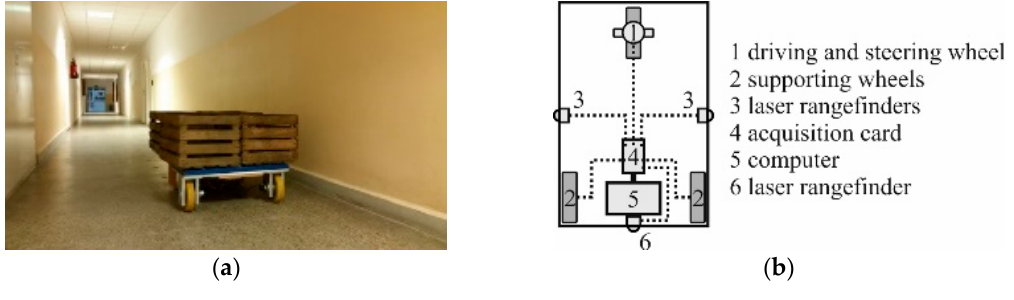
Figure 11. The tested vehicle ( a ) view; ( b ) scheme.